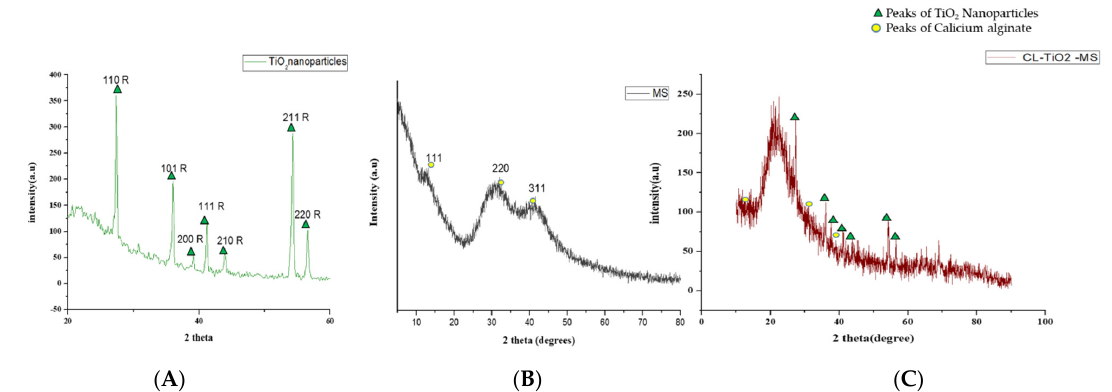
Figure 8. XRD peaks of ( A ) TiO 2 nanoparticles, ( B ) blank MS, and ( C ) CI-TiO 2 -MS.